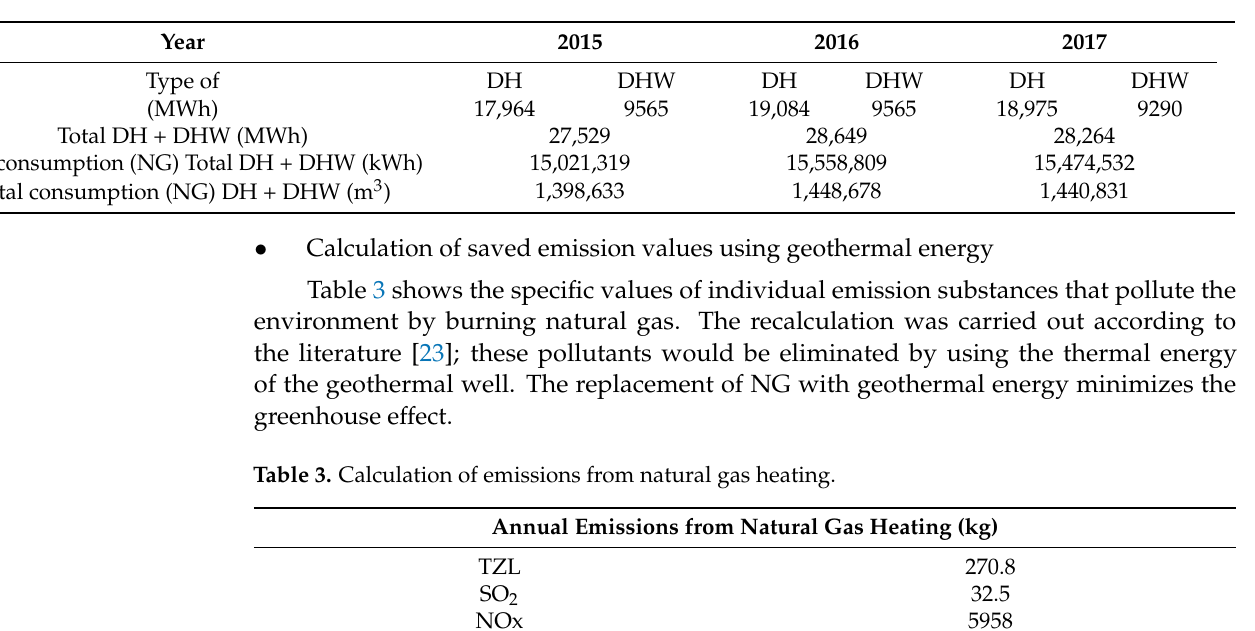
Table 2. Total heat production and consumption of natural gas in the selected location, (source: elaborated by authors).